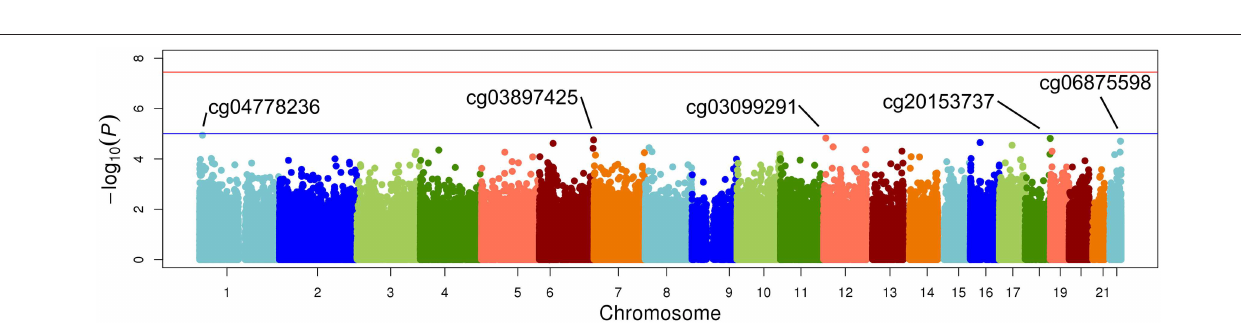
FIGURE 3 | Epigenome-wide Manhattan plot for change in DNA methylation by change in LDL after 3 weeks of daily fenofibrate